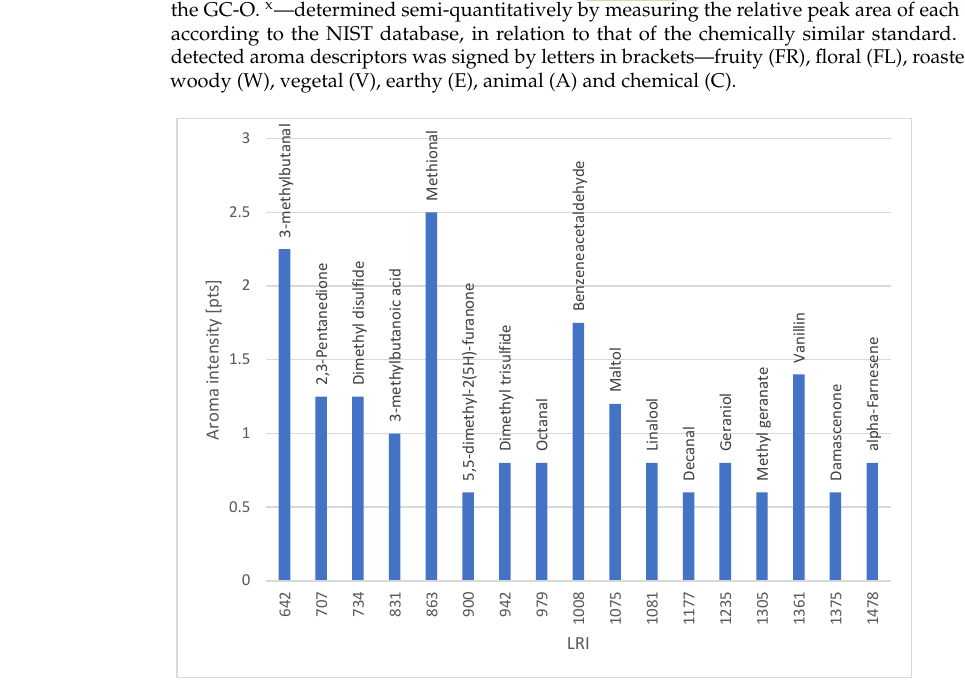
Figure 3. Sensory analysis (QDA) of hopped unfermented wort .